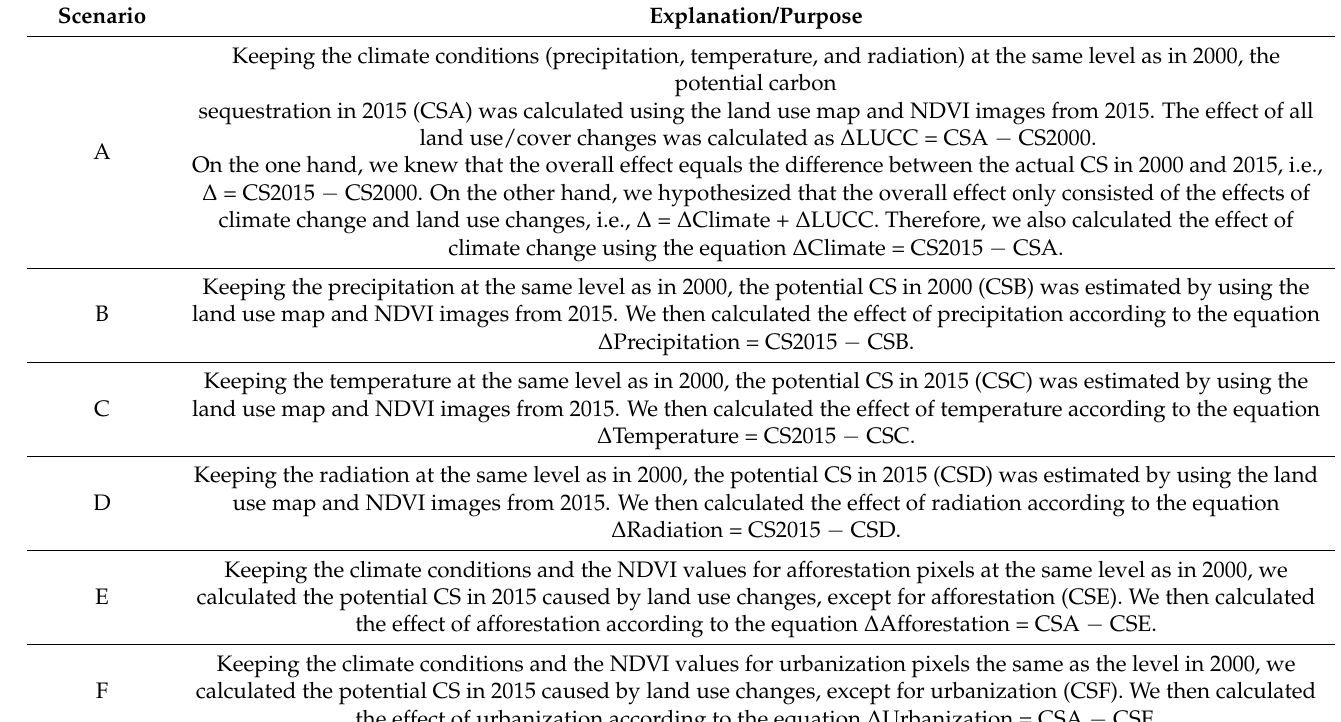
Table 3. Scenario design for quantifying the effects of climate change and land use change on carbon dynamics in the Wuhan City Circle area from 2000 to